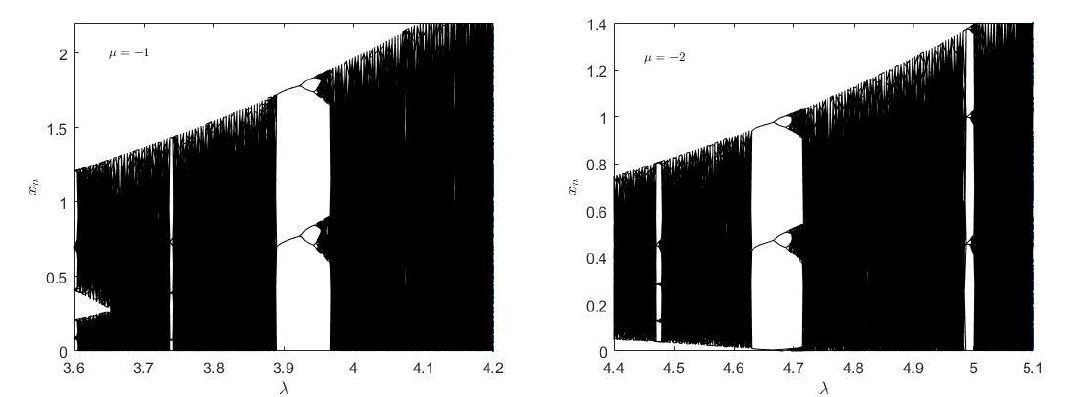
Figure 6. Period-3 window for μ = − 1 Figure 7. Period-3 window for μ = − 2